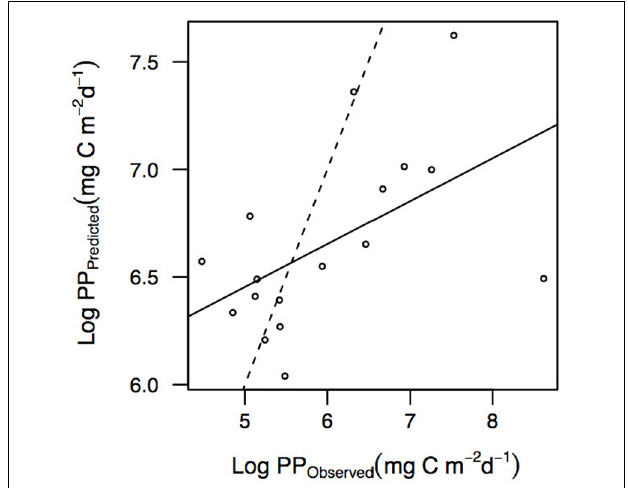
FIGURE 4 | Relationship between the log-log transformed integrated PP Predicted and PP Observed rates (mg C m − 2 d − 1 ) for oceanographic stations where integrated 14 C-POC was available. The dotted line represents the 1:1 lines and the solid line represents the linear regression with equation: Log PP Predicted = 0 . 20 ( ± 0.08) log PP Observed + 5.46 ( ± 0.50), R 2 = 0 . 28, P = 0.02775, n =